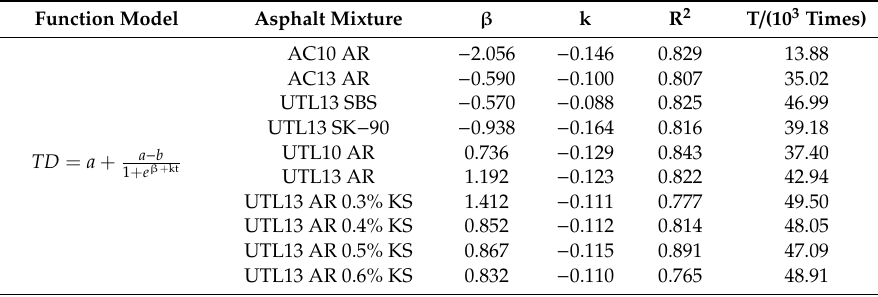
Table 9. The TD model parameters of di ff erent asphalt